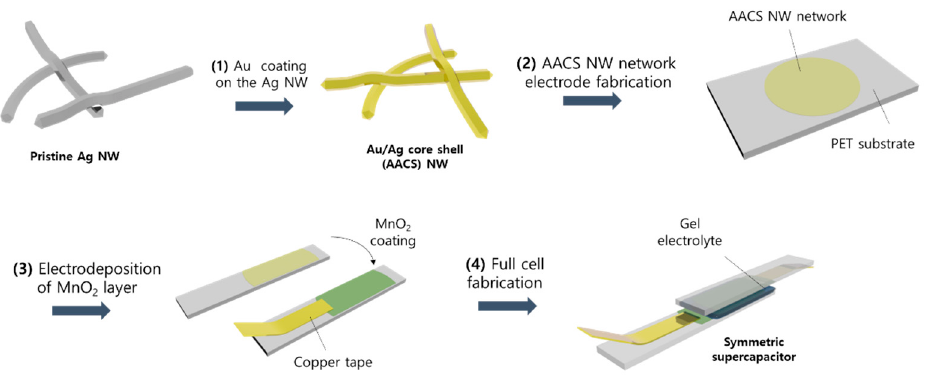
Figure 1. Schematic illustration of Ag/Au/MnO 2 core–shell NW network electrodes and solid state. We used the vacuum filtration and transfer method to form an AACS NW network on the PET substrate. As a control sample, the Ag NW network electrode was prepared through the same method. Figure 2a,b show the SEM images of the Ag NW and AACS NW network electrodes, respectively. In both cases, the NWs with high aspect ratio formed the inter-connected network structures. Furthermore, we performed TEM analysis to investigate the AACS NWs more closely. Figure 2c,d show the TEM images of the pristine Ag NW and AACS NW. In Figure 2c, we observed the definite and ordinary lattice plane and calculated the plane distance using image analysis software. The calculated lattice distances (0.236 nm, 0.204 nm) correspond to the (111) plane and (200) plane of Ag crystal structure (2.359 A, 2.044 A, PDF4-00-004-0783). In the TEM image of the AACS NW